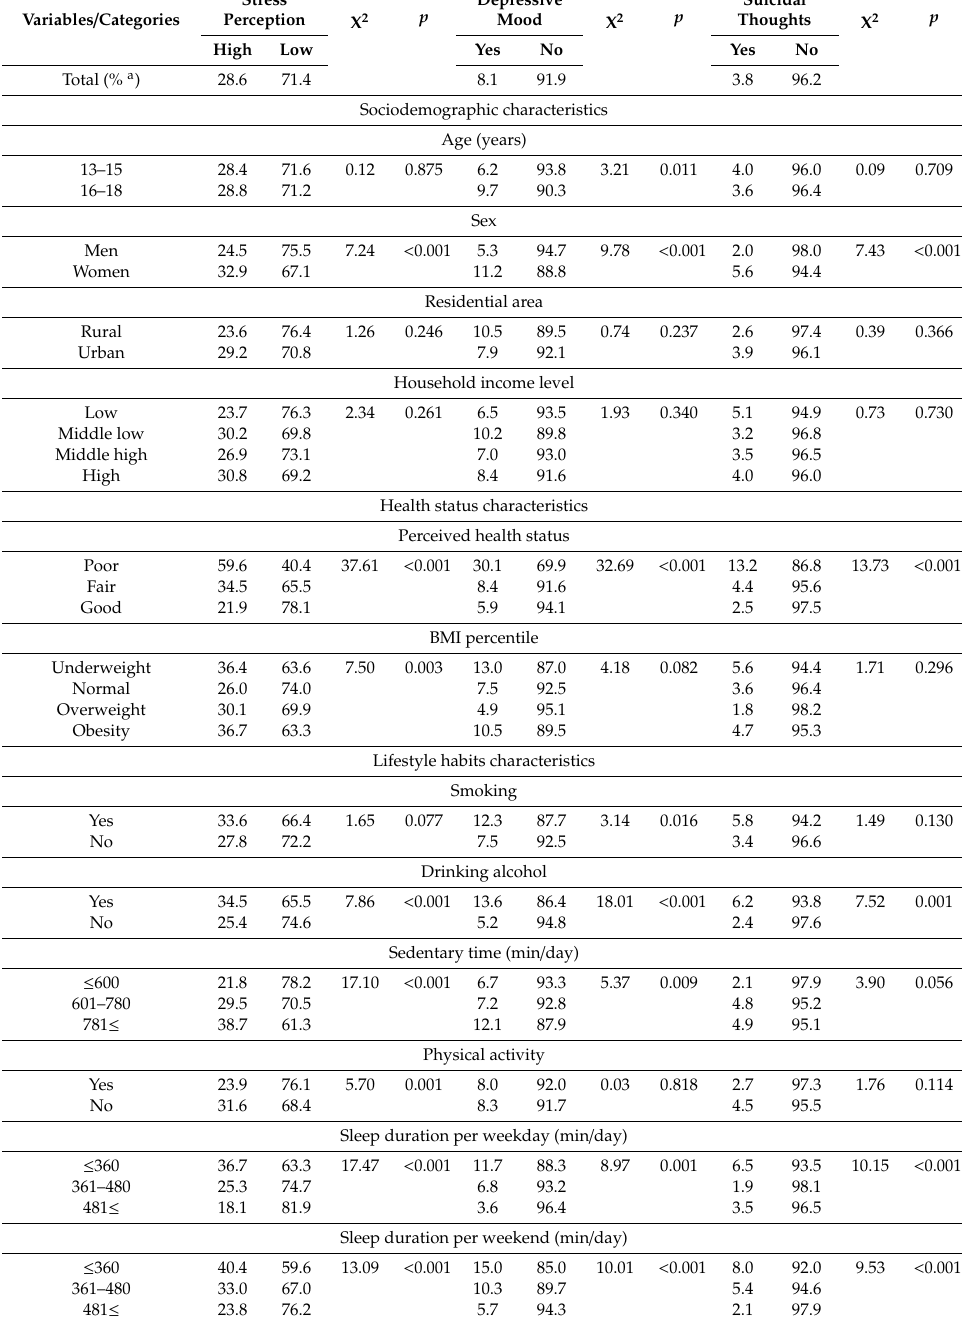
Table 2. Mental health problems according to participants’